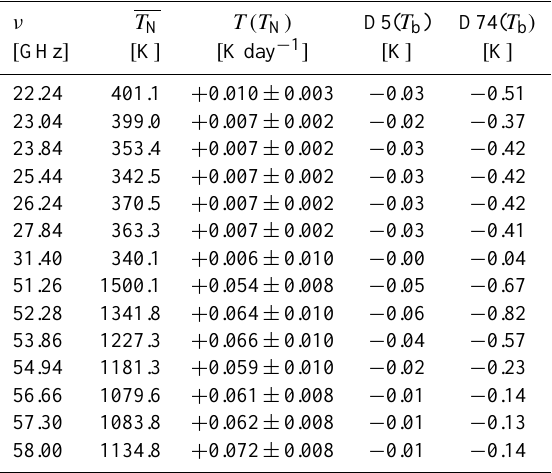
Table 3. Results of 27 liquid nitrogen calibrations performed with HATPRO-G2 at the Jülich Research Center between June 2010 and May 2012. T N is the mean value of the 27 calibrations, T (T N ) is the calculated trend and its uncertainty (confidence interval, Sect. 4.1.5), D5 represents the estimated 5-day drift between 11